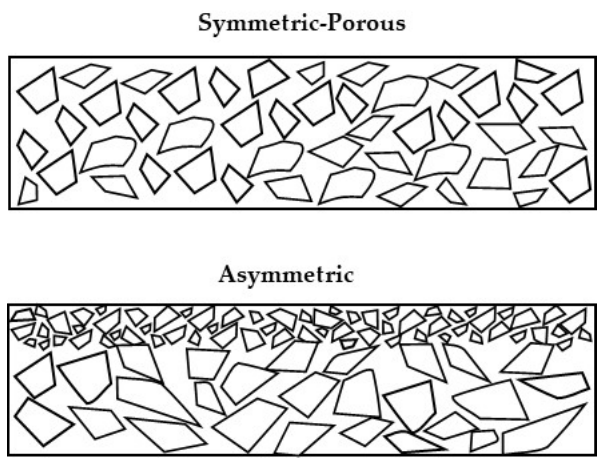
Figure 1. Schematic representation of the difference in structure of a symmetric (porous) and asymmetric membrane (modified from Smith [7], copyright 2013